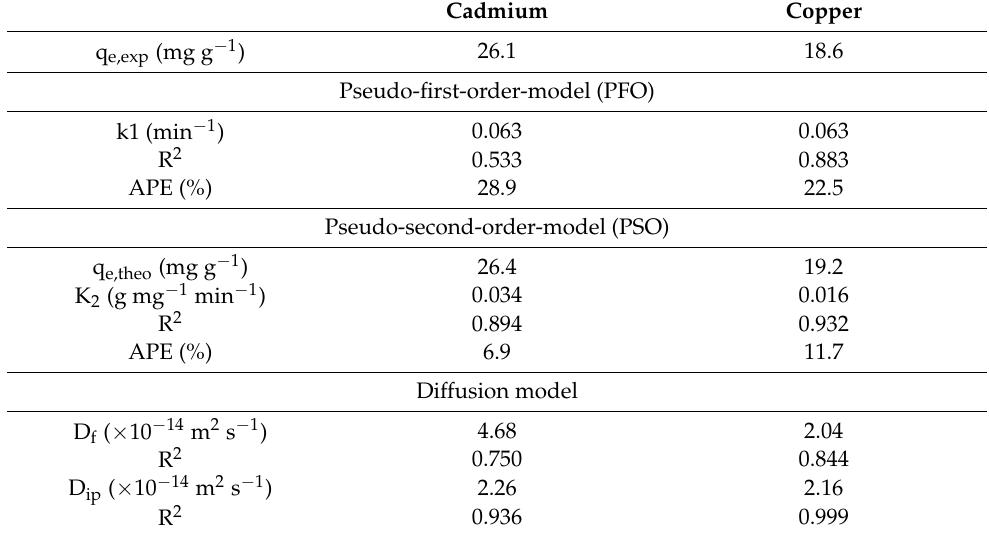
Table 1. Kinetic parameters of Cd and Cu removal by the used lignite (C 0 = 100 mg L − 1 , D = 2 g L − 1 ; t = 60 min; pH = 5; T = 20 ± 2 ◦